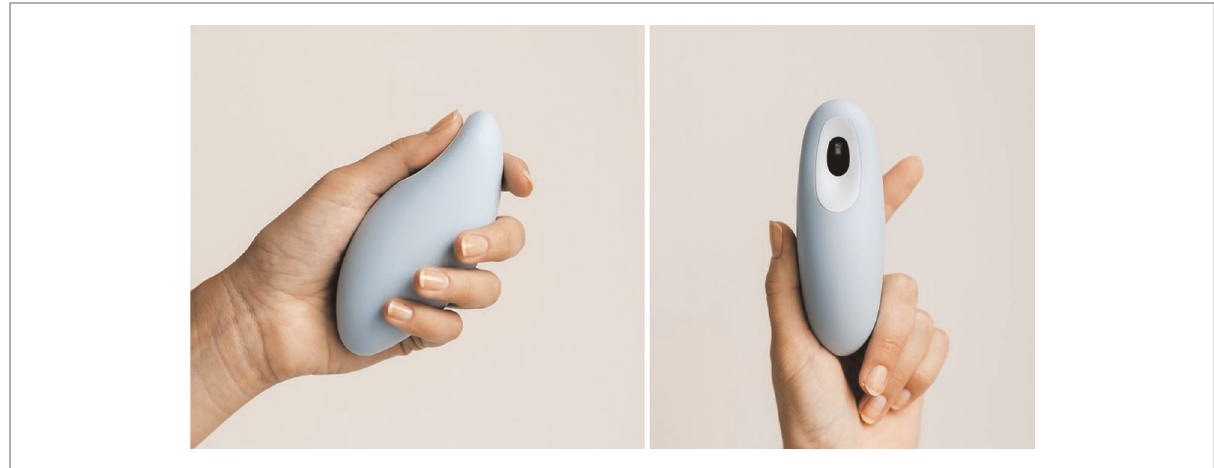
FIGURE 1 The Moonbird breath pacer, including a PPG sensor (right picture).